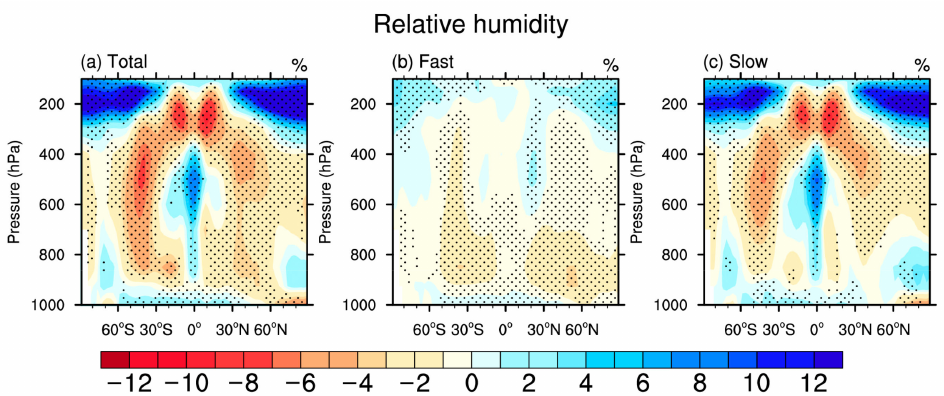
Figure 9. ( a ) Total, ( b ) fast, and ( c ) slow responses of global zonal mean relative humidity (units: %). Black dot represents that at least 8 models agree with the sign of